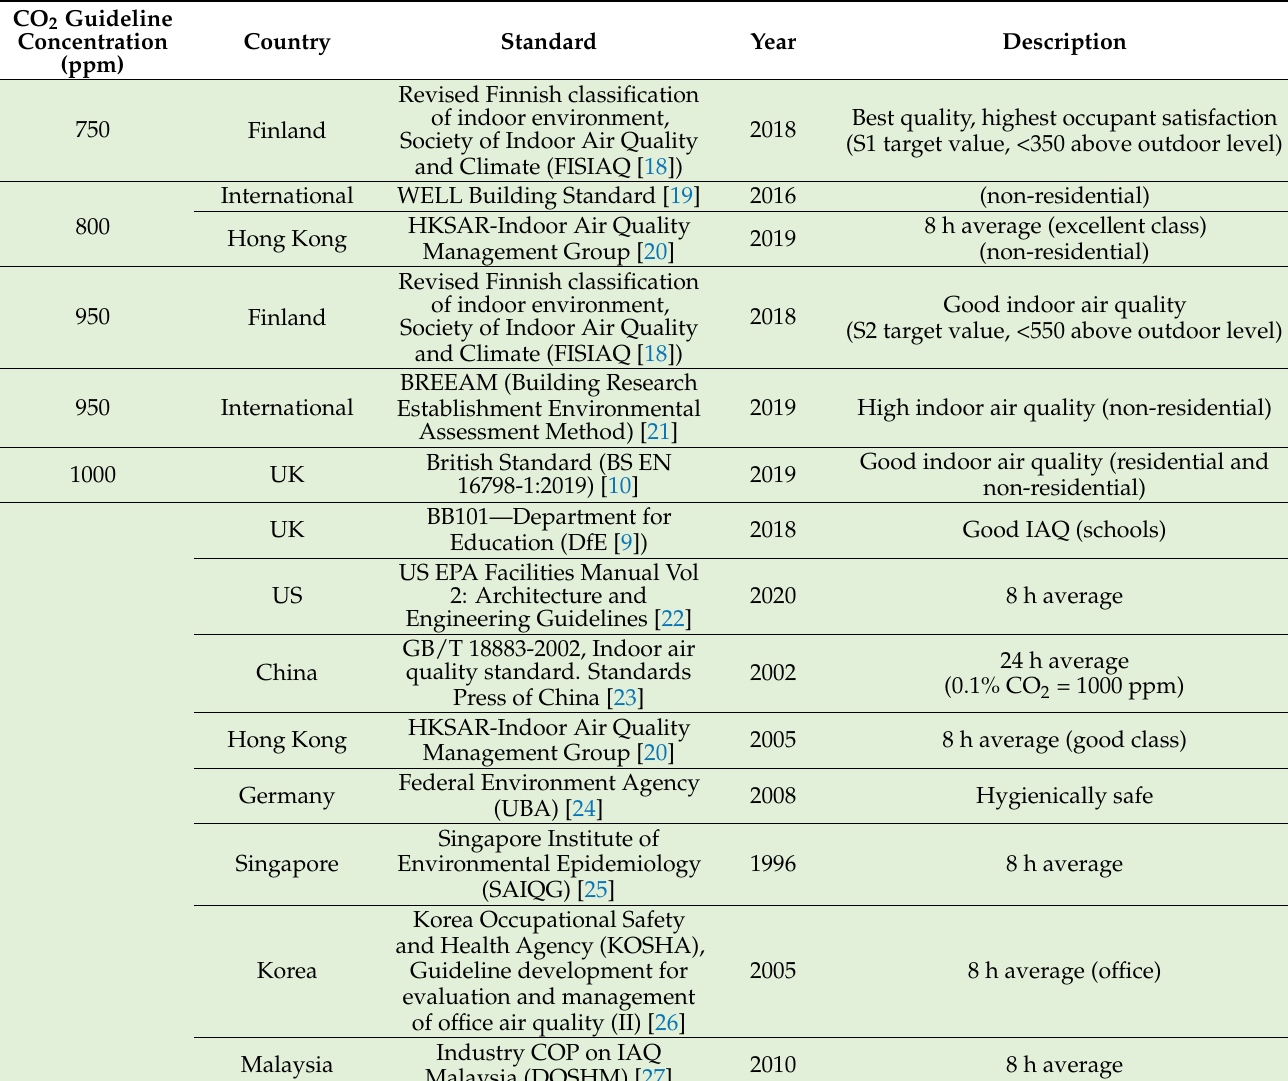
Table 1. A summary of current CO 2 concentration guidelines and limits in indoor environments for different countries and organisations. The colour coding corresponds with the consensus that ≤ 1000 ppm ≈ good, 1000–1500 ppm ≈ moderate and >1500 ppm ≈ poor indoor air